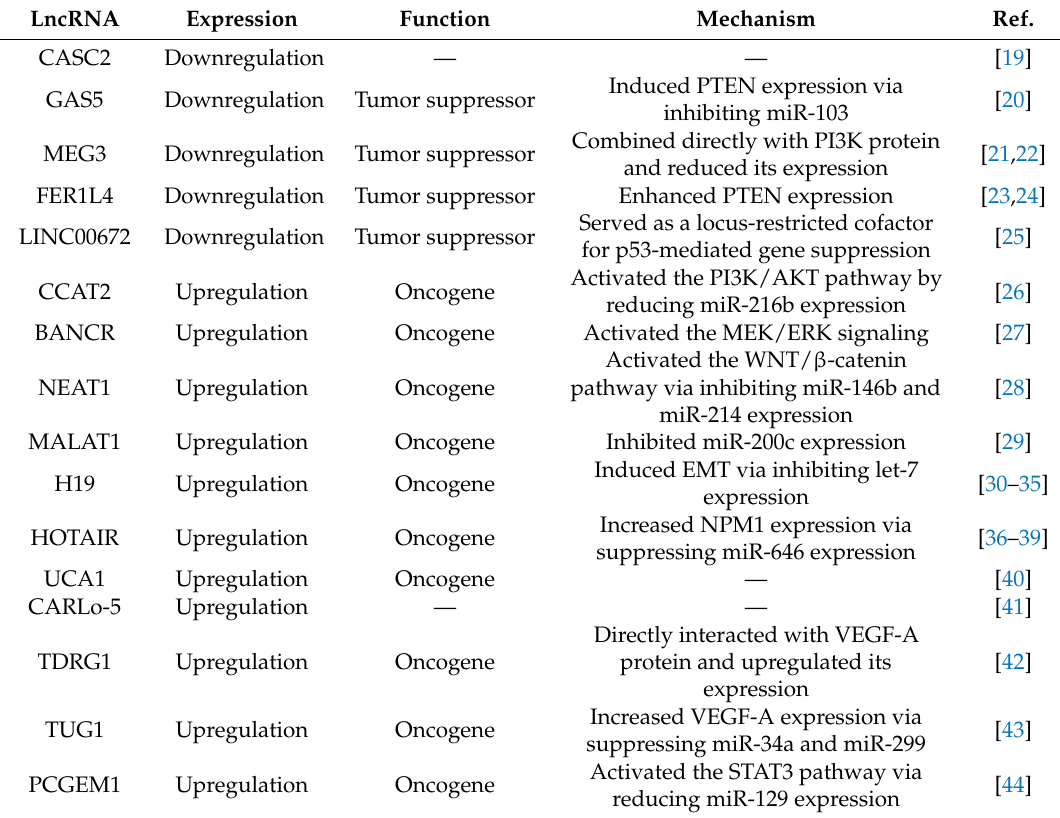
Table 1. The expression, function and mechanism of lncRNAs in